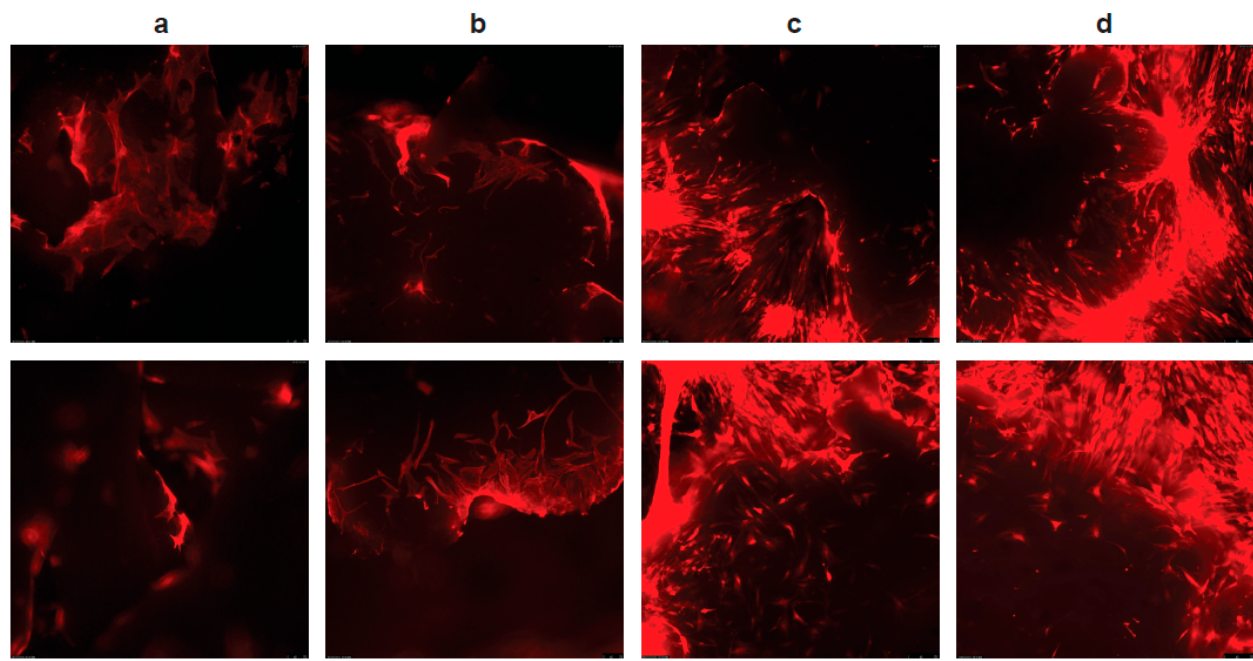
Figure 2. Scanning electron micrograph images of ( A ) a blend of 50:50 and 65:35 poly(lactic-co- glycolic acid) (50:65 PLGA) with 0.05 wt% low-oxygen graphene (LOG) and ( B ) a blend of 50:50 and 75:25 poly(lactic-co-glycolic acid) (50:75 PLGA) with 0.05 wt% low-oxygen graphene (LOG).